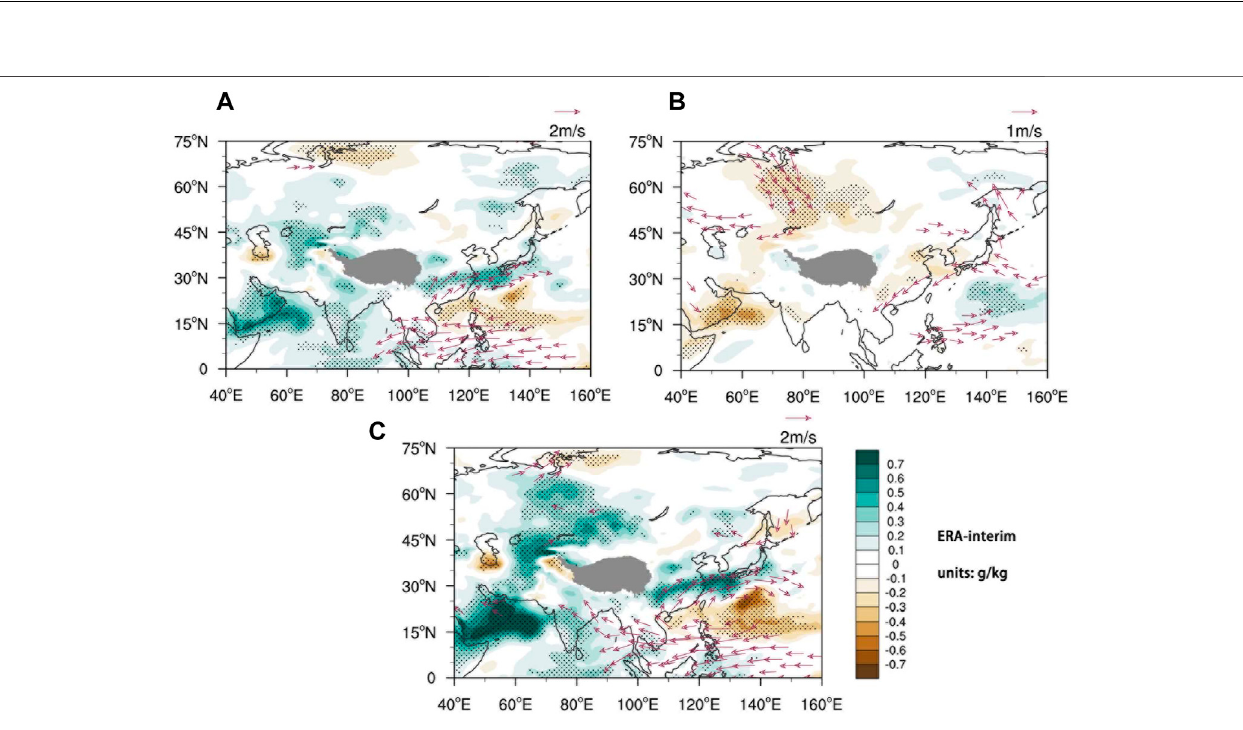
FIGURE 5 | (A) The distributions of background speci fi c humidity at 850 hPa (shadings; units: g/kg; dots are the areas with statistical signi fi cance exceeding the 95% level) and background wind (vectors; unit: m/s; only locally statistically signi fi cant ( > 95%) vectors are shown) and (B) the disturbance kinetic energy at 850 hPa (shadings; units: m 2 s − 2 ; dots are the areas with statistical signi fi cance exceeding the 95% level) and V ″ (vectors; units: m/s; only locally statistically signi fi cant ( > 95%) vectors are shown) during PHREs.